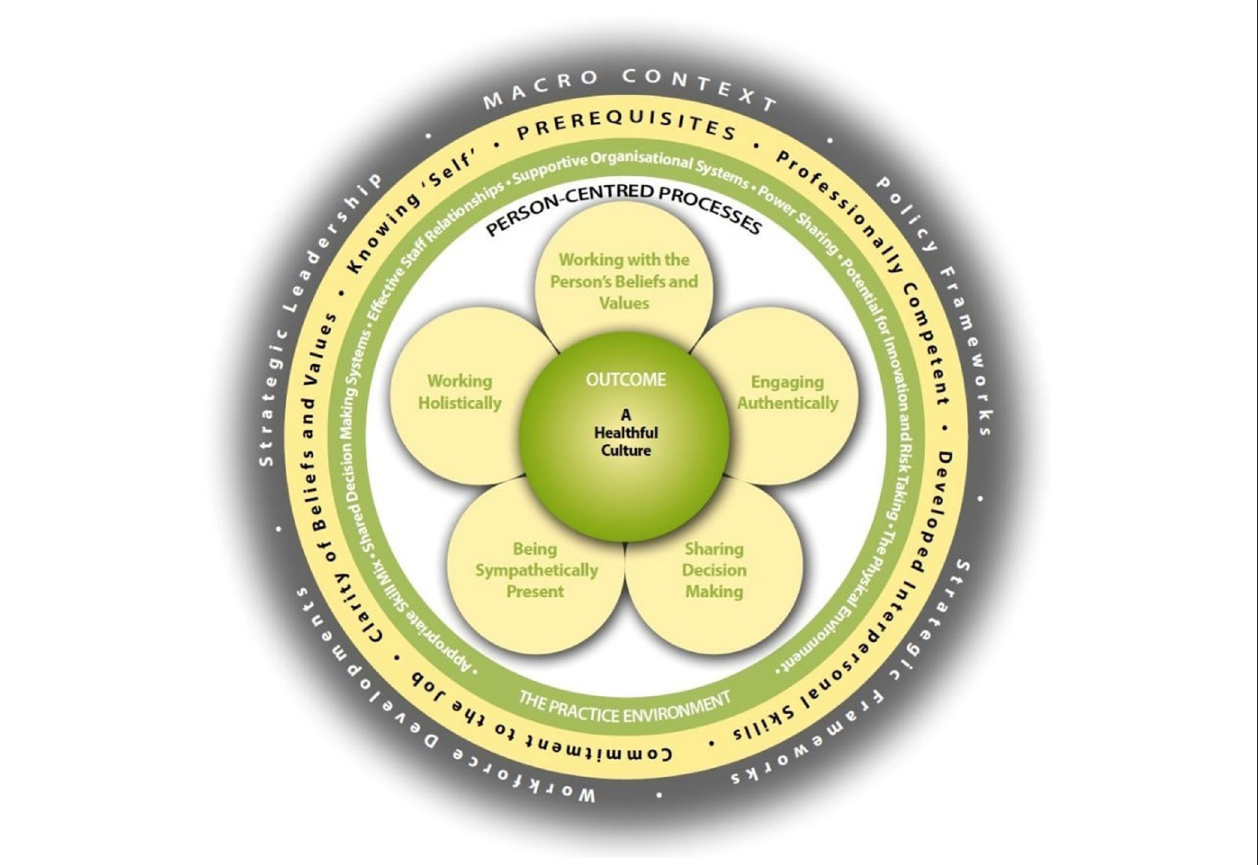
FIGURE 1 | The Person Centered Practice Framework (21). Reproduced with